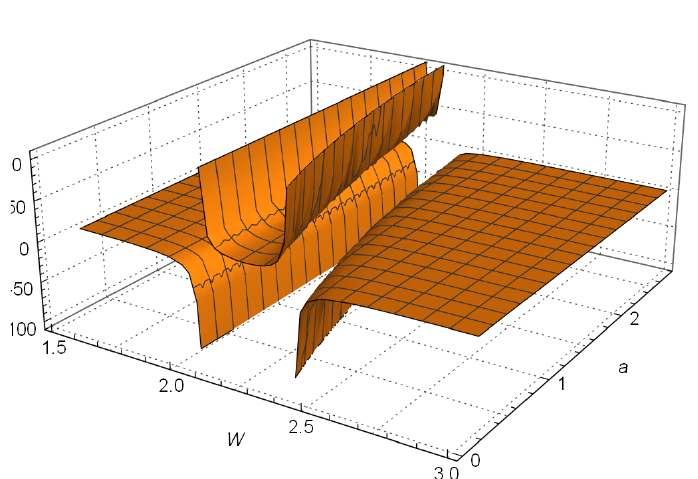
Figure 4. DU ( W ) δ for a = 0.5,1,1.5,2,2.5.